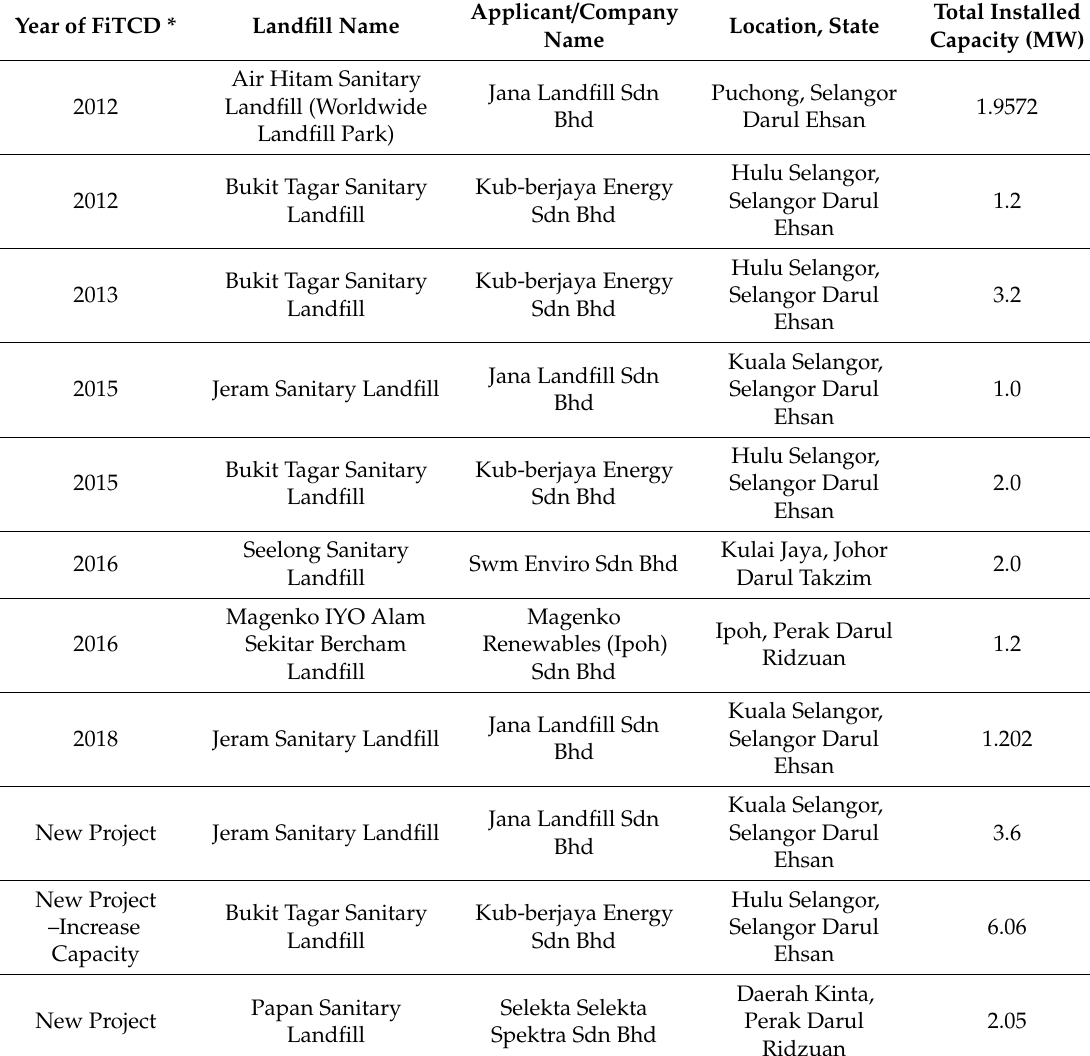
Table 4. List of operating and upcoming landfill biogas plants registered under the Feed-in-Tari ff (FiT) scheme associated with municipal solid waste (MSW) landfill to energy (Source: SEDA, Sustainable Energy Development Authority